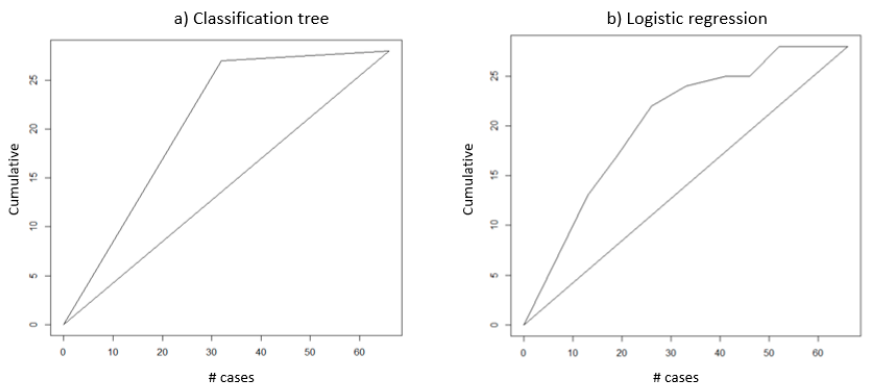
Figure 6. Lift Chart for Validation Data.